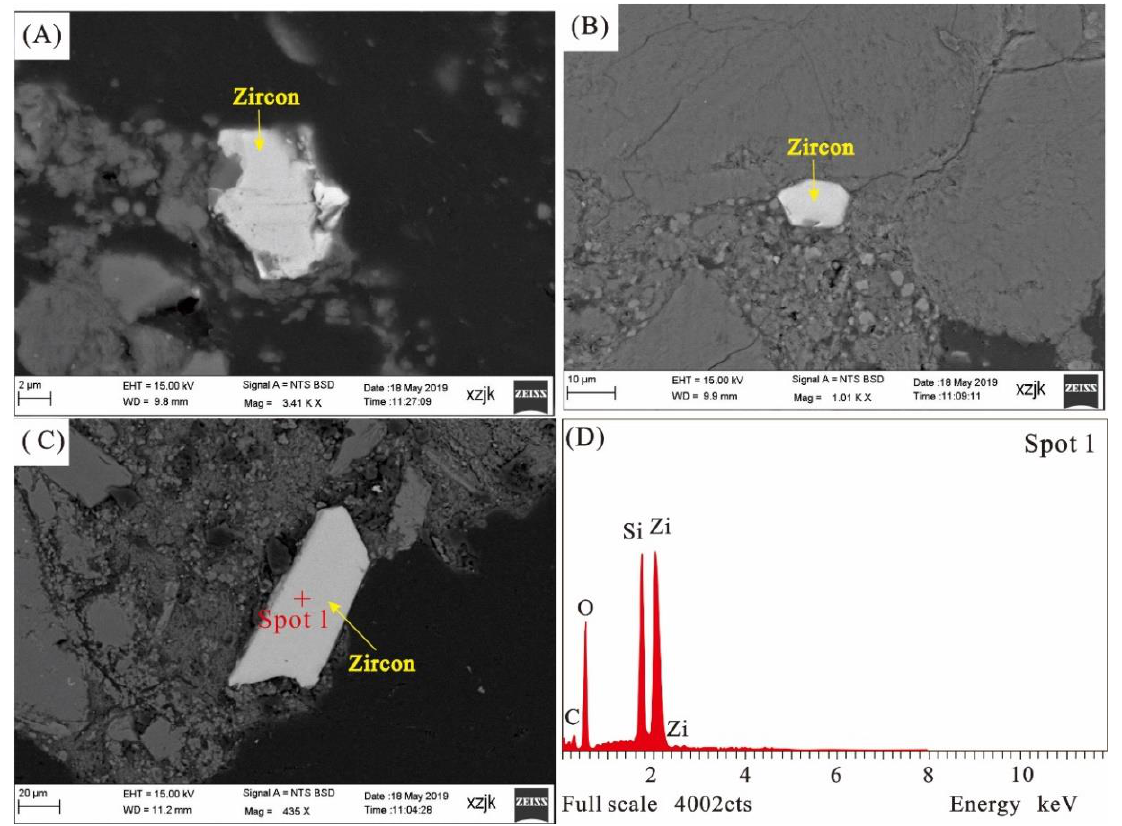
Figure 11. Zircon in samples from Junde mine. ( A ) Sample JD-26-03; ( B ) Sample JD-26-05; ( C ) Sample JD-26-06. ( D ) EDS spectrum of Spot 1 in Figure